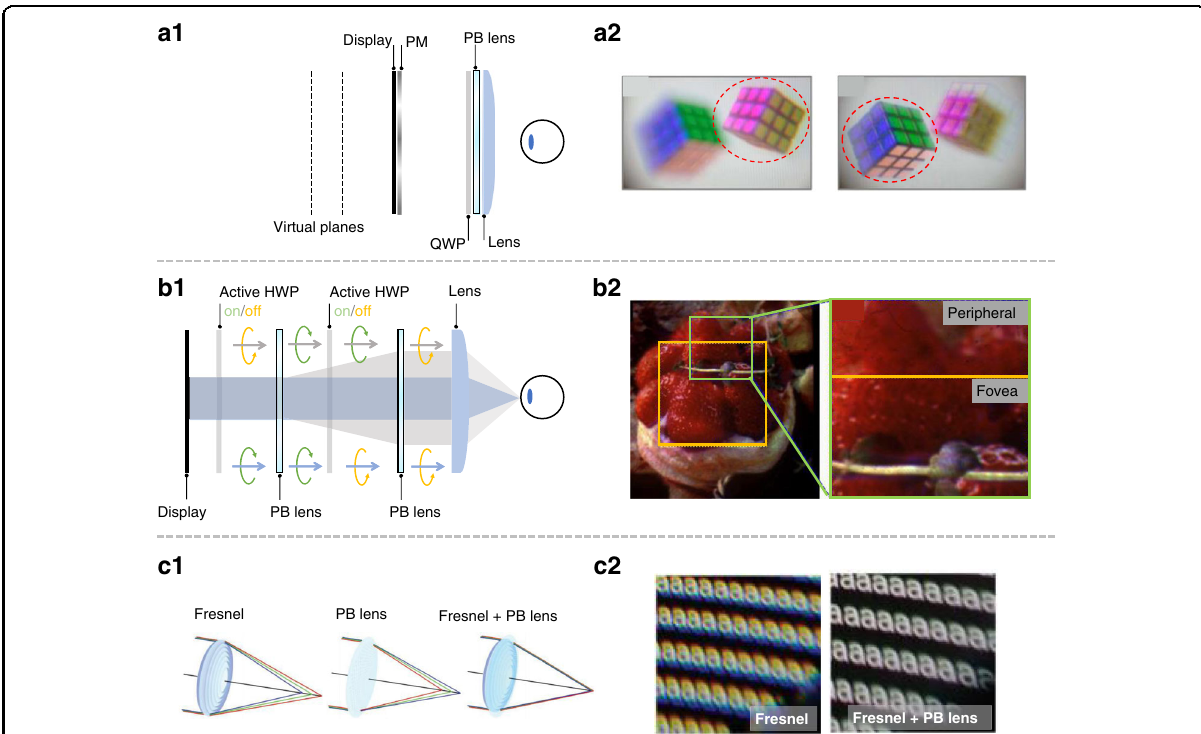
Fig. 11 Applications of transmissive LC lens in AR/VR. a1 Polarization multiplexing based multiplane VR system with a2 experimental results. b1 Foveated VR system with b2 experimental results. c1 Chromatic aberration correction for VR system with c2 experimental results. Reprinted from a2 ref. 185 with permission from The Optical Society, b2 ref. 186 with permission from The Optical Society, c2 ref. 188 with permission from John Wiley and